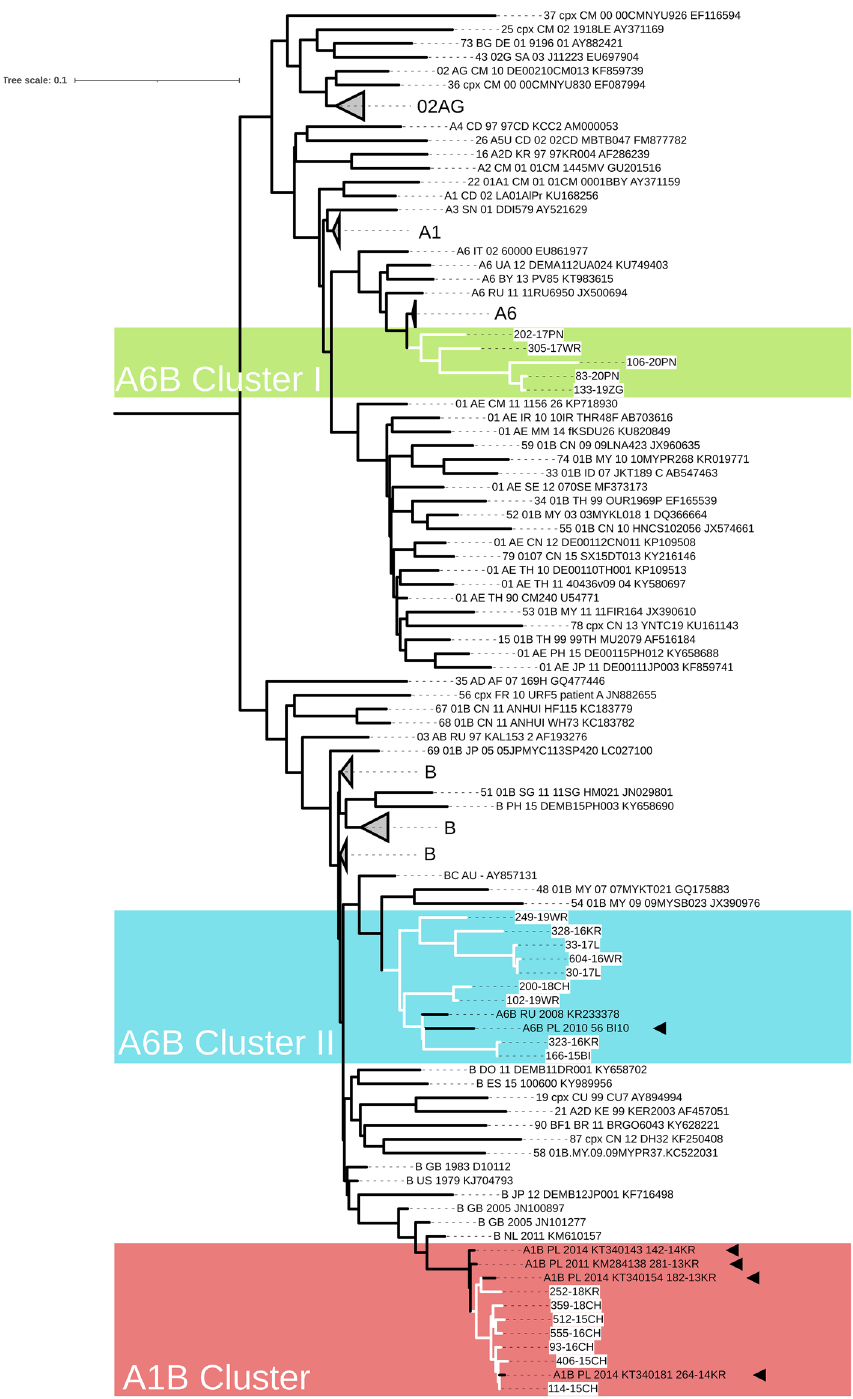
Figure 3. Phylogenetic tree of partial HIV-1 pol sequences (1302 bp) inferred using ML method with HIV-1 reference from HIV sequence compendium 2017 (all A and B subtypes sequences and CRFs with at least one fragment of either A or B variant), supplemented with HIV-1 sequence database-deposited sequences for subtype A and B recombinants with 21 unique recombinant forms found in the studied group. White highlights indicate A/B recombinant sequences. The black triangles mark the URF sequences found in our previous publication (from 2008–2014). Branches containing the same HIV-1 clade have been collapsed. The tree was rooted with group O (accession no KY953205), however, this root was removed from the final figure. The Figure was made using iTol